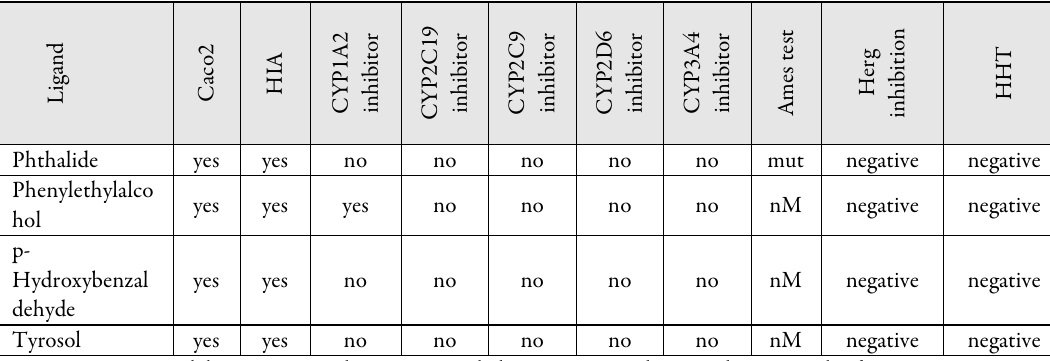
Table 4. Result of ADMET of top ligands